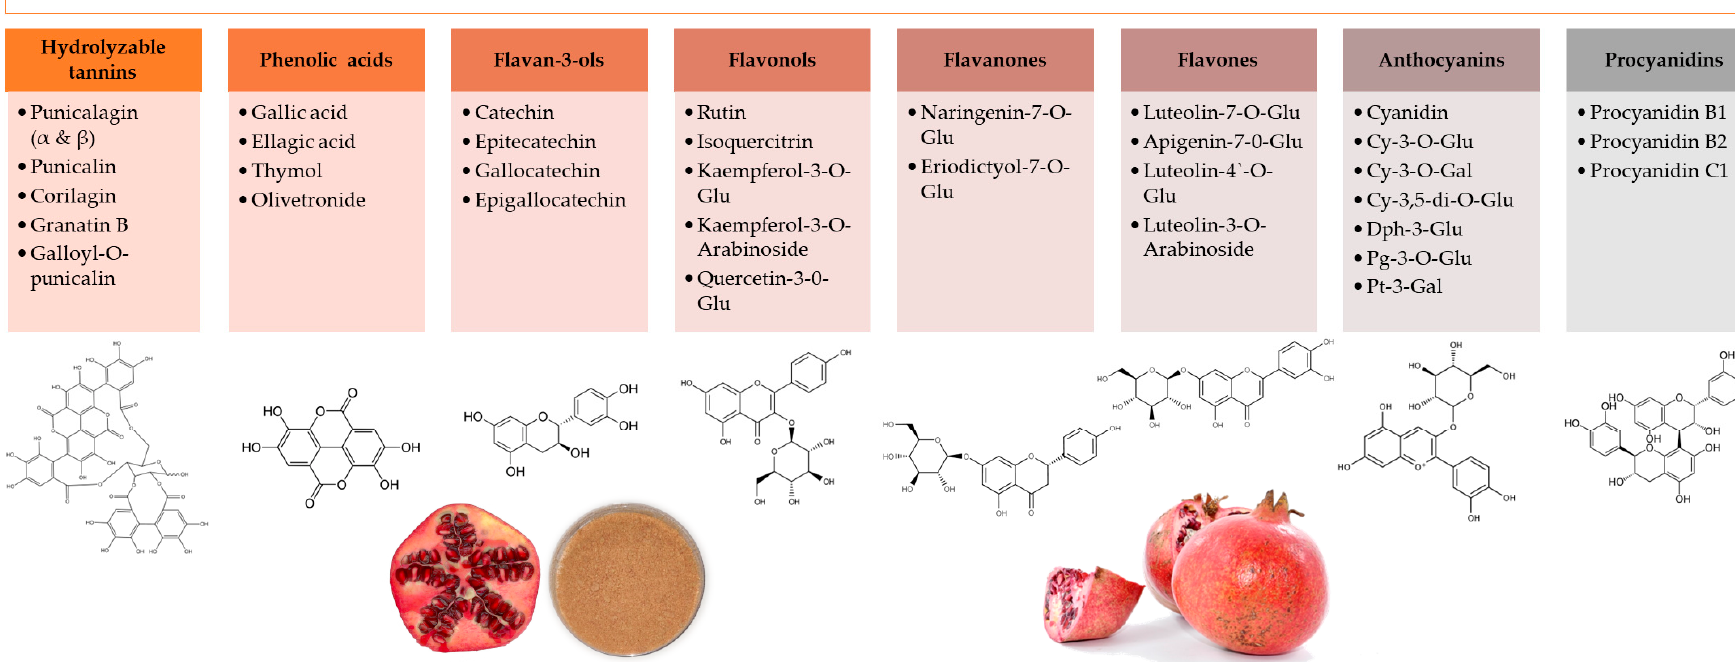
Figure 2. Classification of the main phenolic compounds in pomegranate peel [5,15]. Glu: glucoside; Cy: cyanidin; Dph: delphinidin; Pg: pelargonidin; Pt: petunidin; Gal: galactoside.